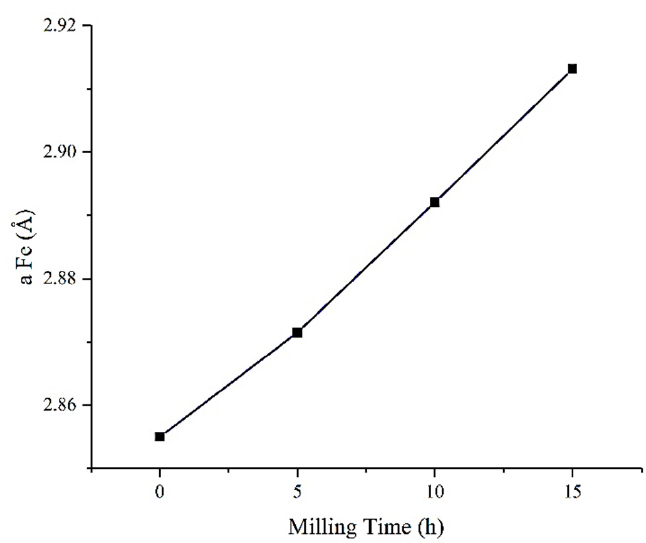
Figure 3. Fe lattice constant after different milling